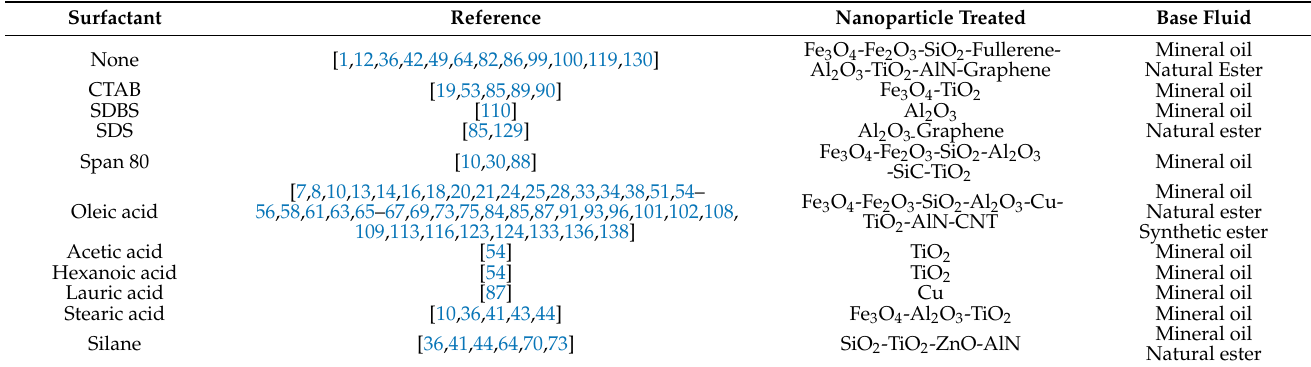
Table 7. Surfactants that were used in thermal-dielectric nanofluids.